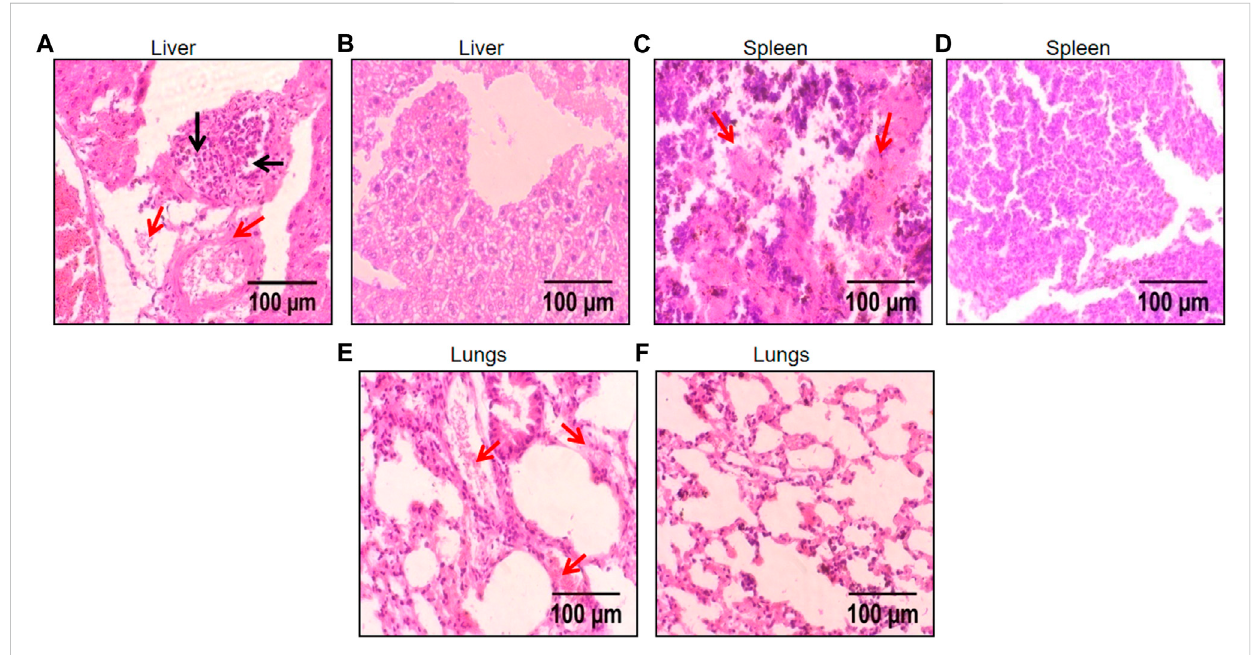
Histologicalimagesofliver,spleen,andlungsdepictingprotectiveeffectofFLNinSCDmice.TherepresentativeH&Estainedliver,spleen,andlungs tissue at ×40 magni fi cation under the light microscope; (A) disease control liver (B) FLN treated liver (C) disease control spleen (D) FLN treated spleen (E) disease control lungs (F) FLN treated lungs. The black arrow indicates in fl ammatory cell in fi ltration and the red arrow indicates congestion by sickled